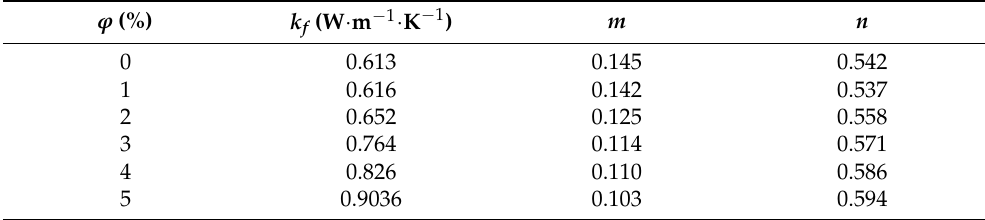
Table 2. The thermal conductivity and applied indices of the non-Newtonian nanofluid for different volume fractions adopted from